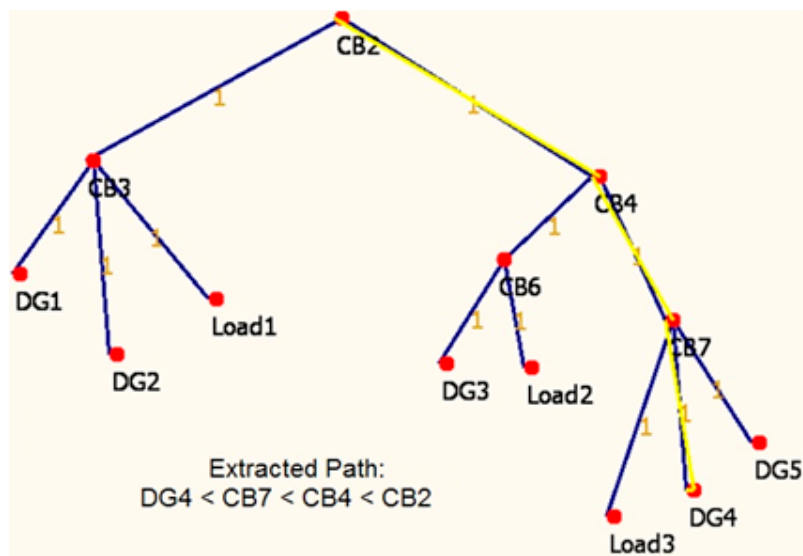
Table 1. Path from “Circuit Breaker 2”.